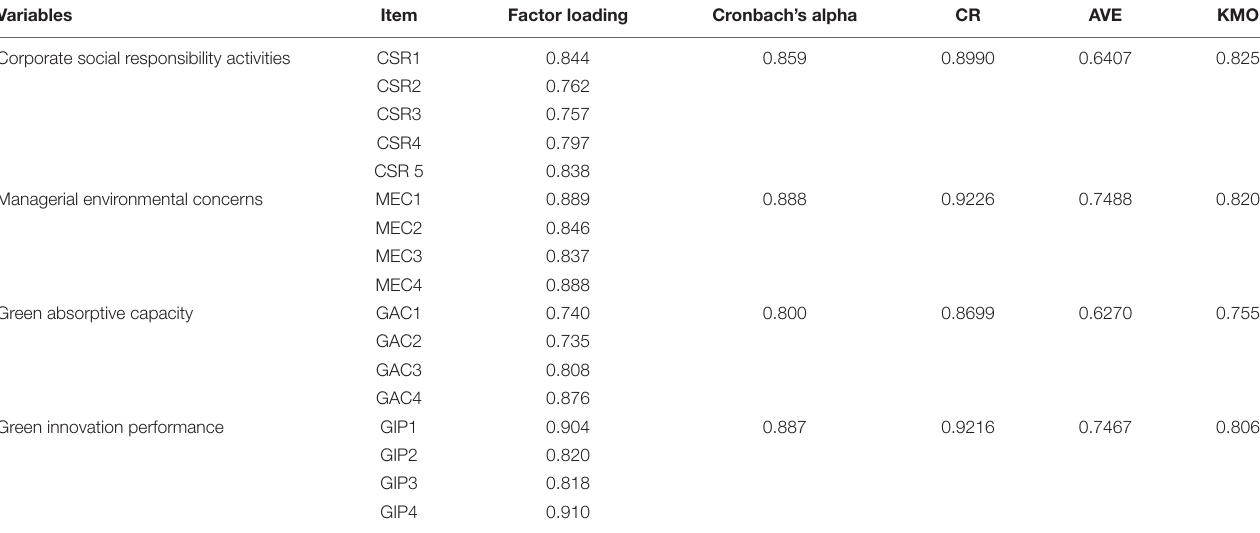
TABLE 2 | Reliability and validity analysis results of each latent variable.